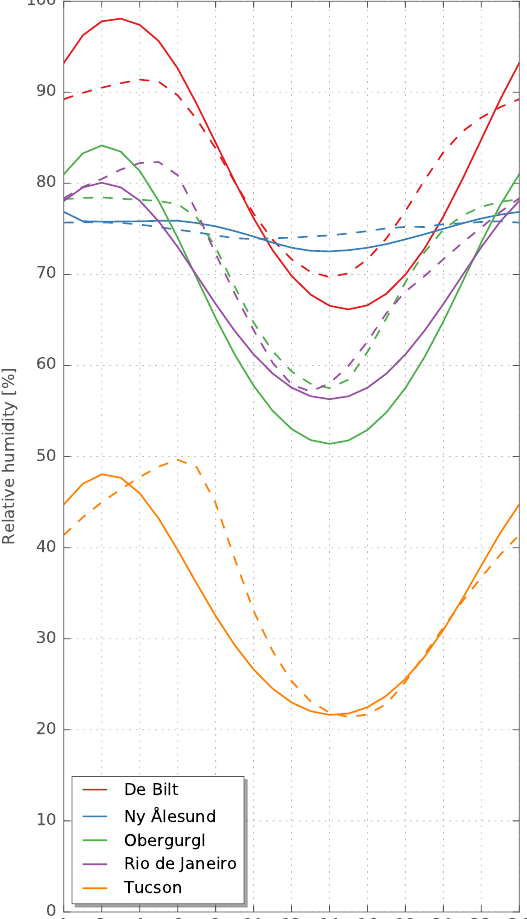
Figure 10. Long-term averages of diurnal courses of observed (dashed) and disaggregated (solid) relative humidity (H3 model). The period of time involved in this analysis is listed in Table 1 for each